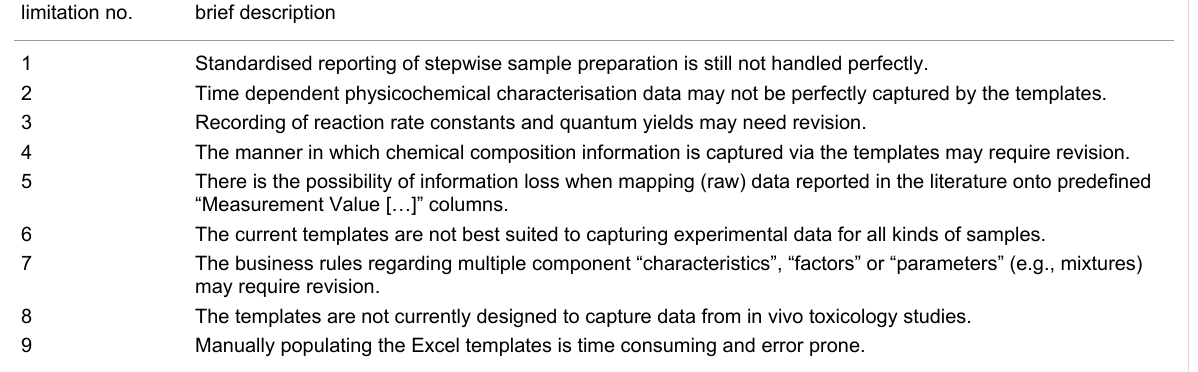
Table 4: Summary of some notable limitations of the NanoPUZZLES templates and business rules. limitation